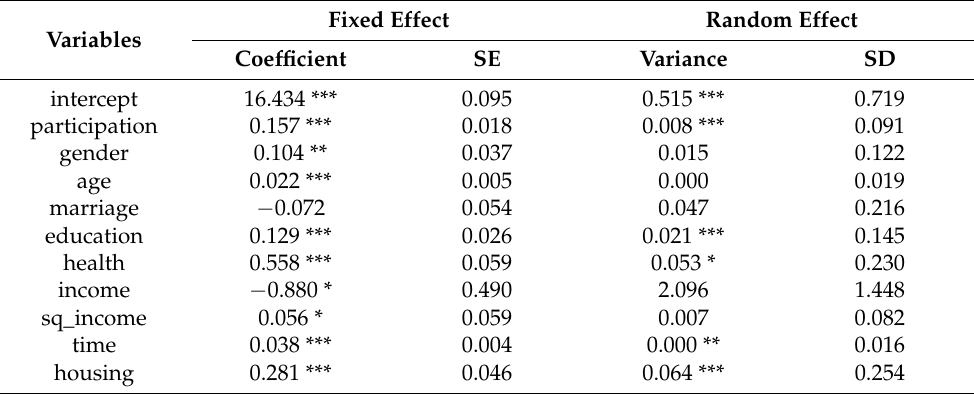
Table 4. Results of the random effects model on the influencing factors of the perceived social integration new urban immigrants.